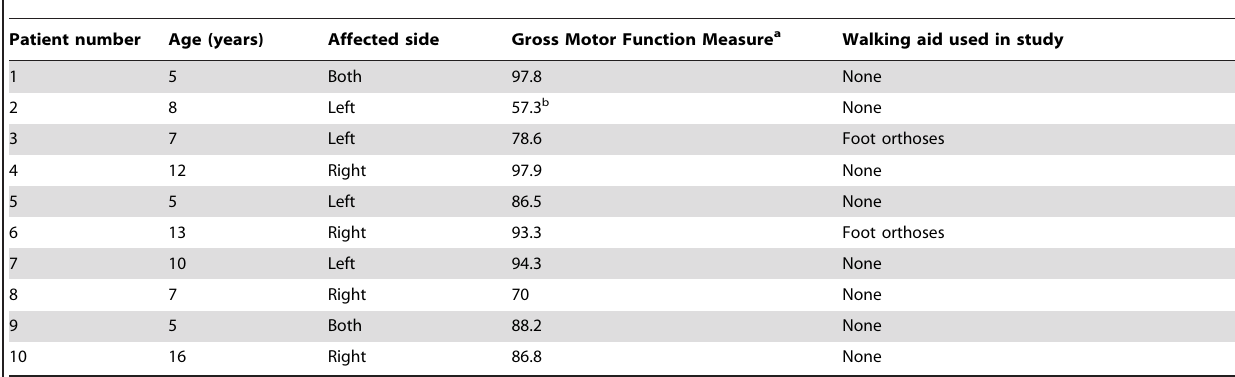
Table 1. Demographic data and experimental details for children with hemiplegia.